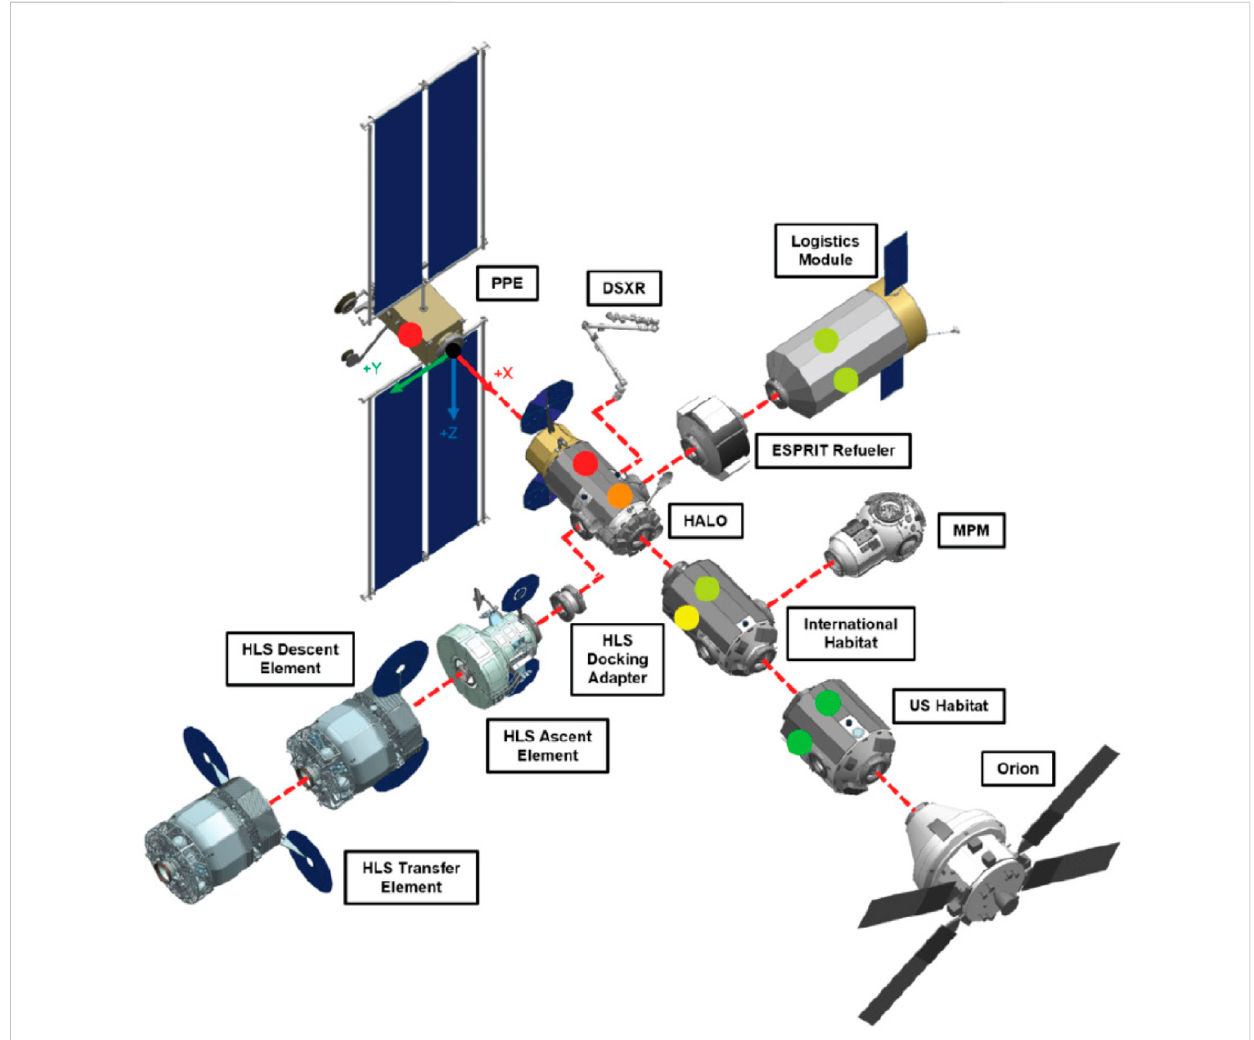
FIGURE 15 Quality of the different positions on the Gateway for placing the space plasmas